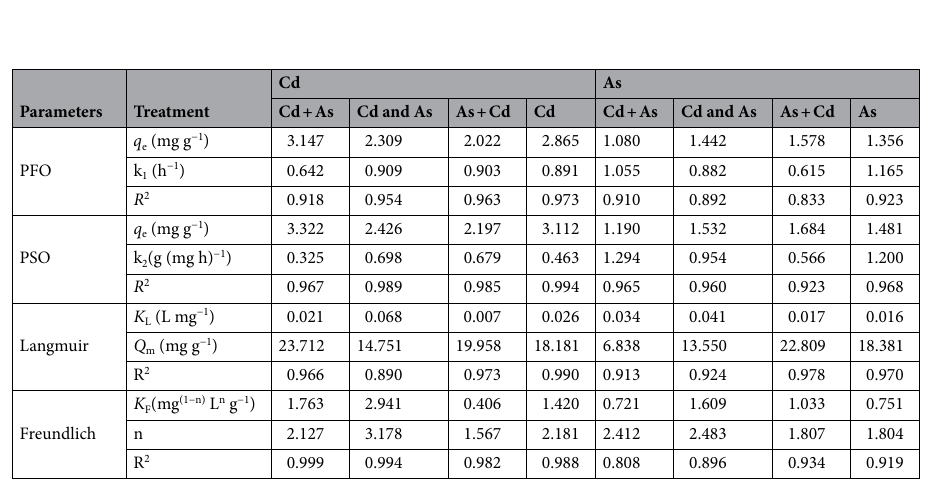
Table 1. Kinetics and isotherms parameters for As (III) and Cd(II) adsorption on Fh@BC (25 °C) in the single solution or binary solution (with a simultaneous or sequential addition).